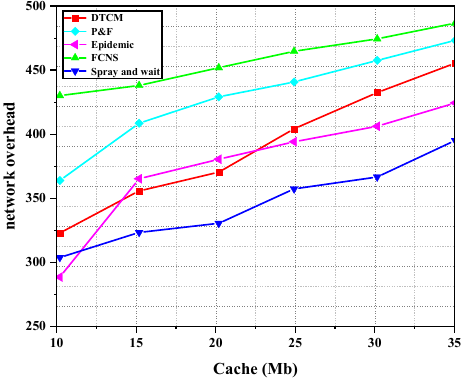
Figure 10. Network overhead comparison from five algorithms with various cache spaces.